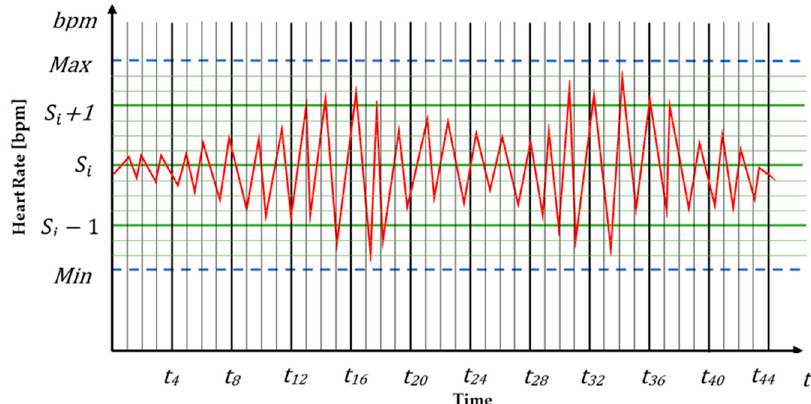
Figure 7. Analysis of operator heart rate measurement .